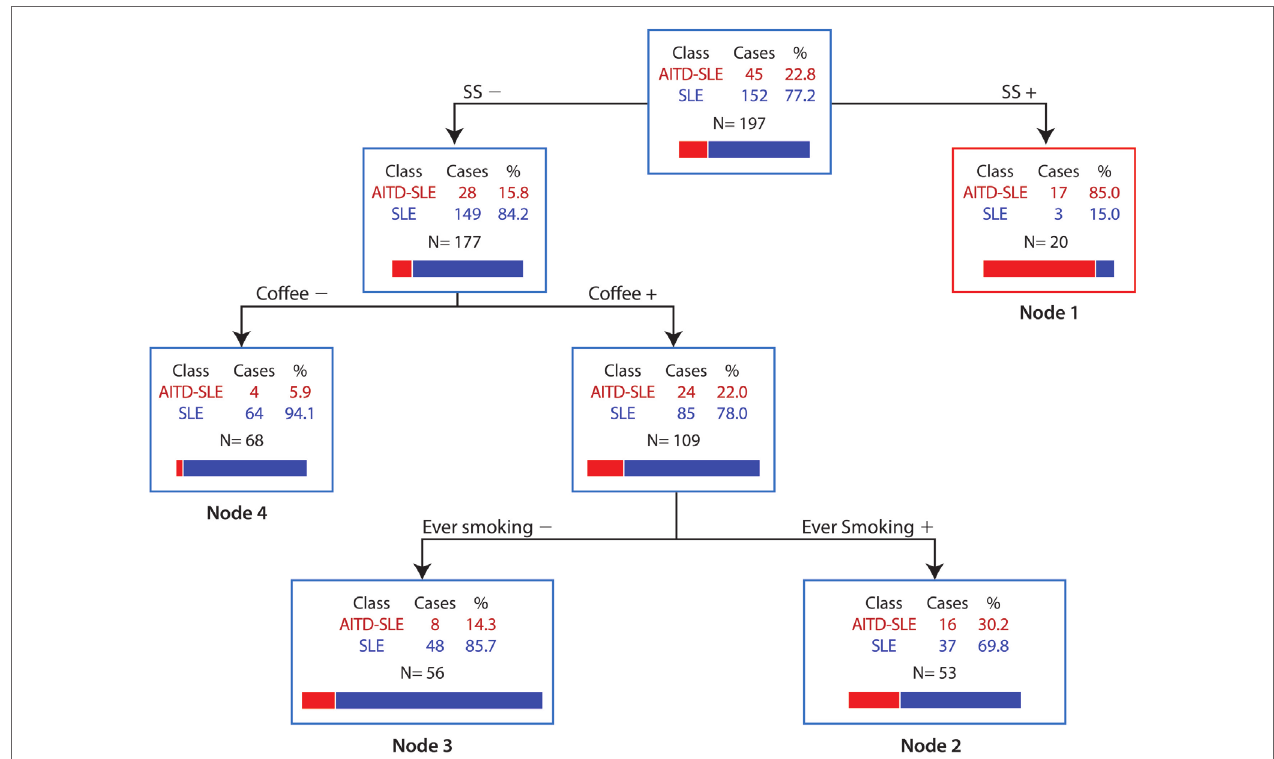
FiGURe 10 | Predictive factors associated with AiTD PolyA in SLe . Sjögren syndrome and ever smoking are the main factors associated with the development of AITD in SLE. AITD, autoimmune thyroid disease; PolyA, Polyautoimmunity; SLE, systemic lupus erythematosus; SS, Sjögren’s syndrome. Adapted from Ref.